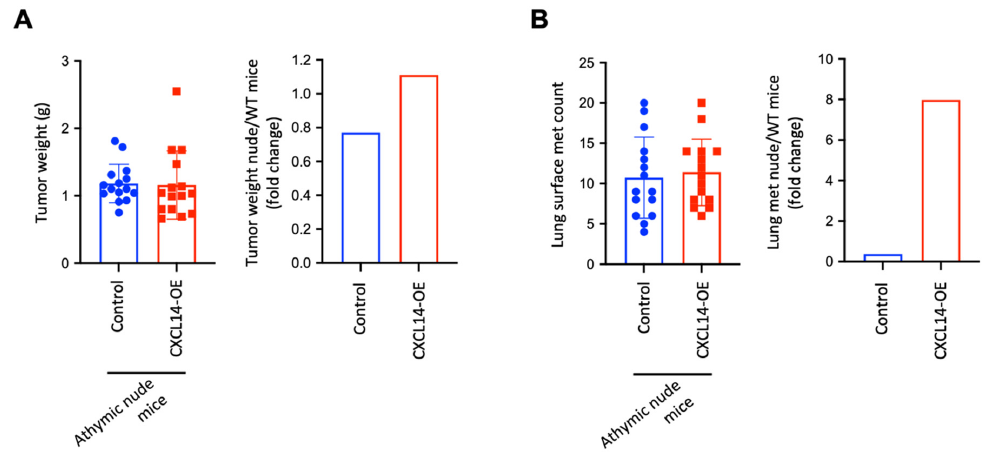
Figure 5. T cell-dependent effects of CXCL14 on tumor growth and metastasis. ( A ) Left panel: tumor weights of Control and CXCL14-OE 4T1 cells in T cell-deficient athymic nude mice ( n = 15); right panel: fold changes of tumor weights in nude mice compared with WT mice. ( B ) Left panel: number of lung metastases of Control and CXCL14-OE 4T1 cells in T cell-deficient athymic nude mice ( n = 15); right panel: fold changes of lung met counts in nude mice compared with WT mice. Data are presented as mean ± SD.